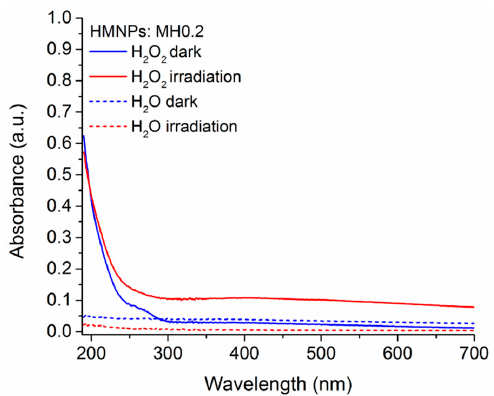
Figure 2. HMNP stability in solution: UV–Vis spectra of either water (dotted line) or 1.5 × 10 − 3 M H 2 O 2 (solid line) solutions after being in contact with MH0.2 for 2 h either in the dark (blue) or under irradiation (red).